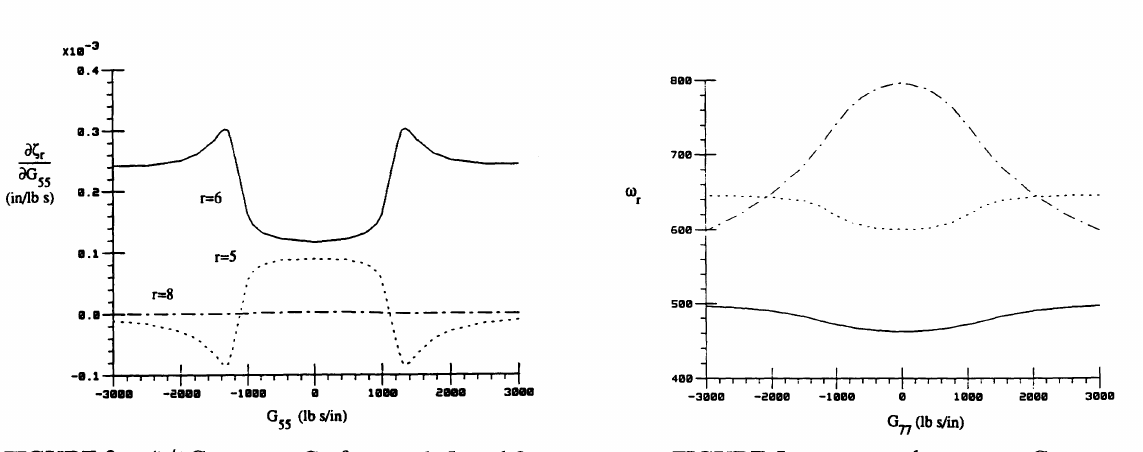
FIGURE 5 W5, W6, and Wg versus G